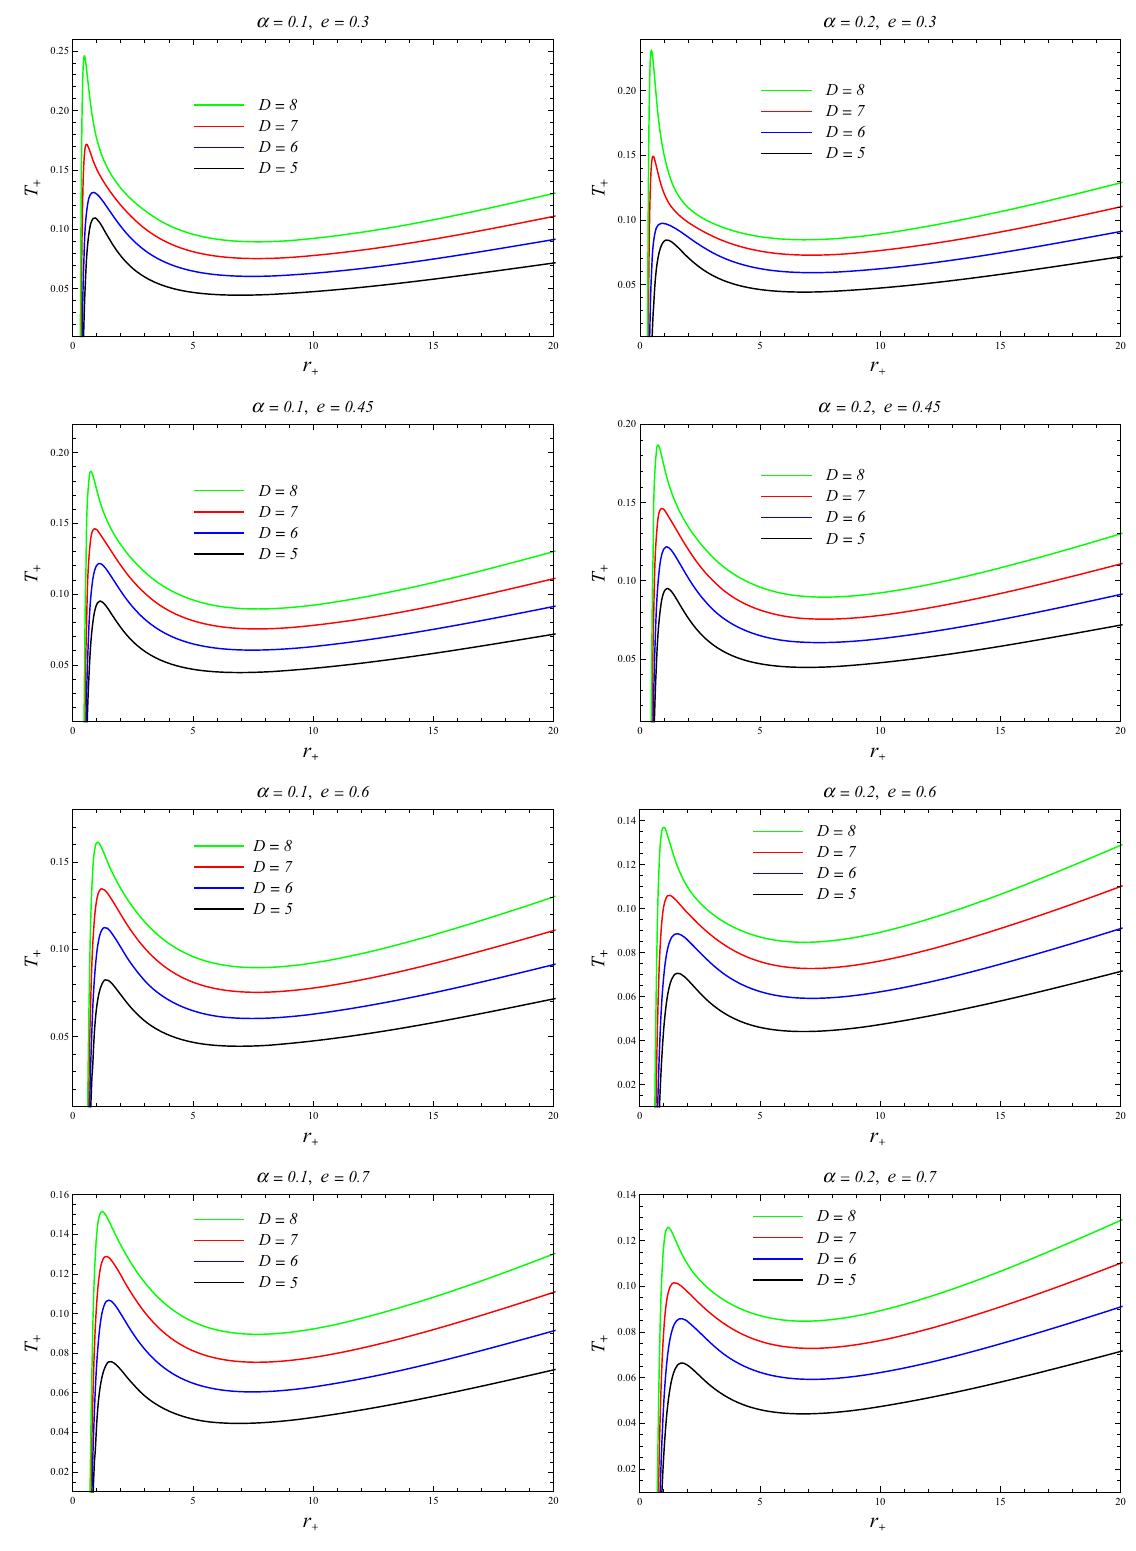
Fig. 3 The Hawking temperature T + vs horizon radius r + for different values of charge e = 0 . 3, 0.45, 0.6, 0.7 (top to bottom) with Gauss–Bonnet coupling parameter α = 0 . 1 and 0.2 (left to right) in various dimensions with μ (cid:9) =